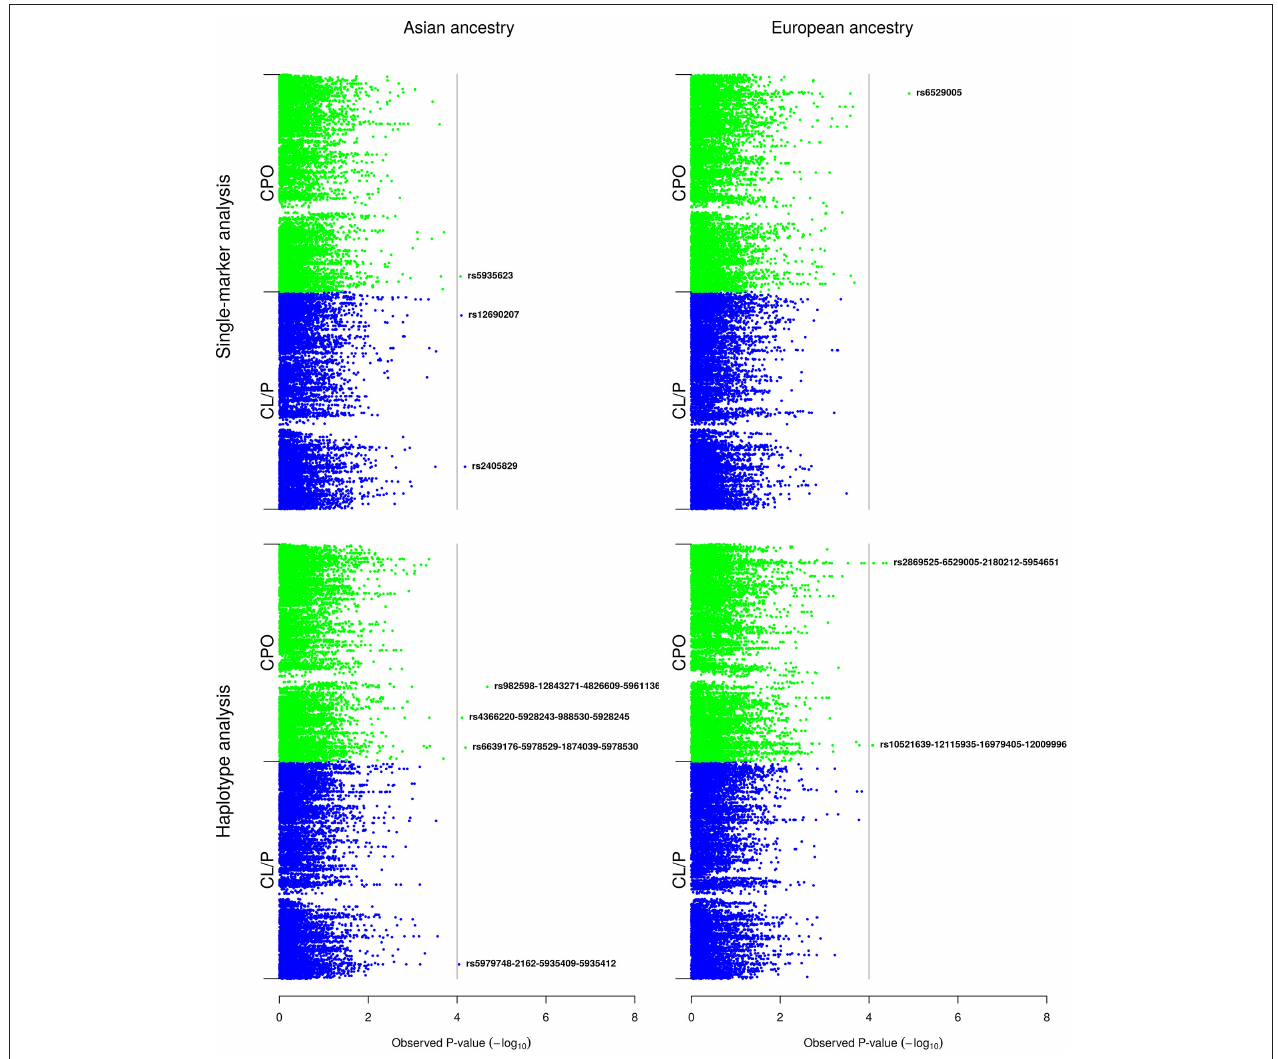
FIGURE 3 | Single-marker and haplotype analyses in the Asian and European girls only. The Manhattan plots show the single-marker and haplotype analyses of the girls only. For convenience, we have added a vertical line corresponding to a Bonferroni-corrected p -value cutoff of 10 − 4 .